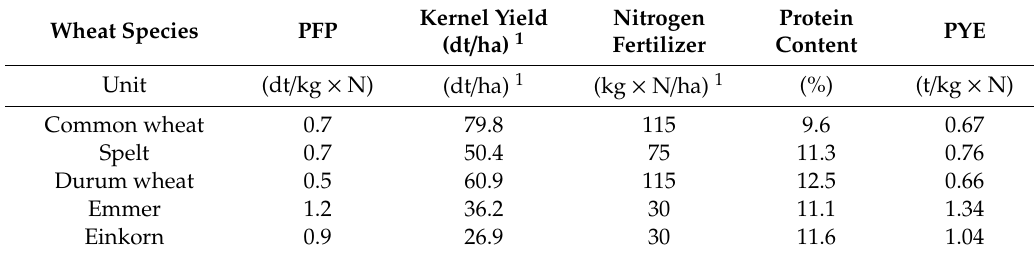
Table 2. Nitrogen partial factor productivity (PFP) and protein yield e ffi ciency (PYE) of common wheat, spelt, durum wheat, emmer and einkorn. PFP is calculated as ratio of kernel yield (in decitonnes (dt) per hectare (ha), i.e., 10,000 m 2 ) and quantity of nitrogen fertilizer (in kg of nitrogen (N)). PYE is calculated as ratio of protein yield, which is the product of protein content (in %) and kernel yield, and quantity of fertilizer. Kernel yield, quantity of nitrogen fertilizer and protein content are means over all cultivars at all four locations within the wheat